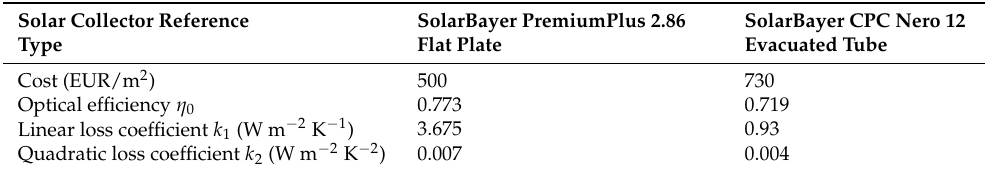
Table 2. Solar collector types, costs, and performance data